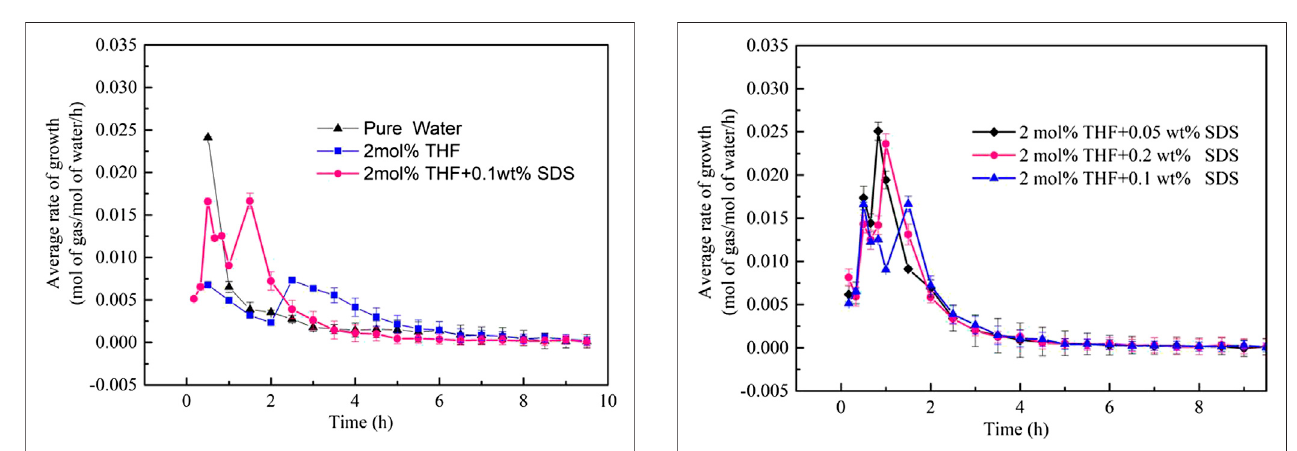
FIGURE 9 | Rate of CO 2 hydrate formation at different initial molar concentrations of